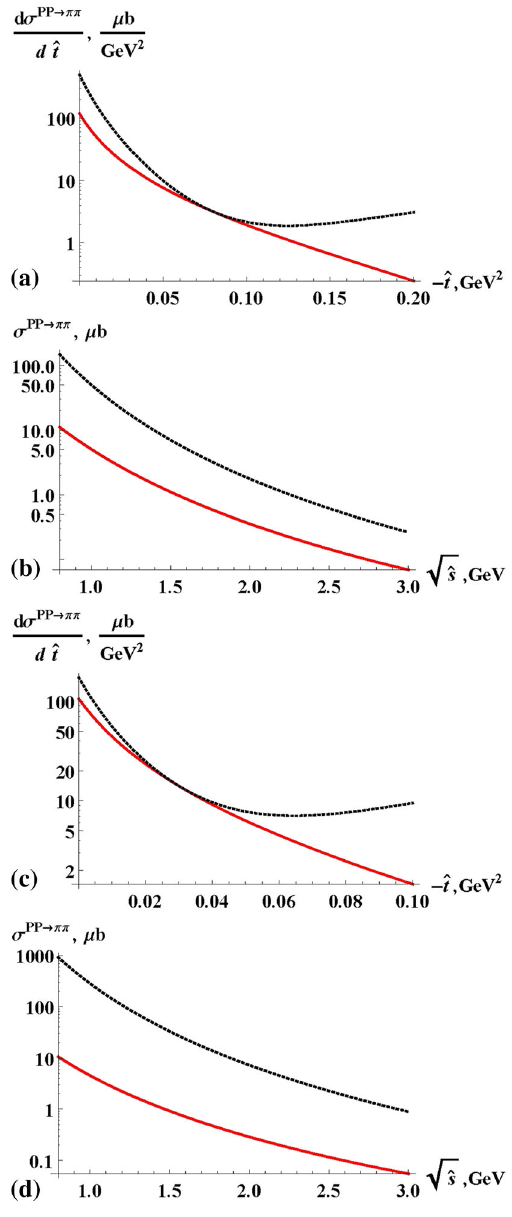
Fig. 15 Results of calculations (15)–(17) for Pomeron–Pomeron to pion–pion cross-section for t 1 , 2 = − 0 . 1 GeV 2 (a,b) and t 1 , 2 = − 0 . 05 GeV 2 (c,d). Two curves present cases of non-conserved (solid) √ ˆ s = 1 . 5 GeV in (a), and conserved (dotted) hadronic currents.